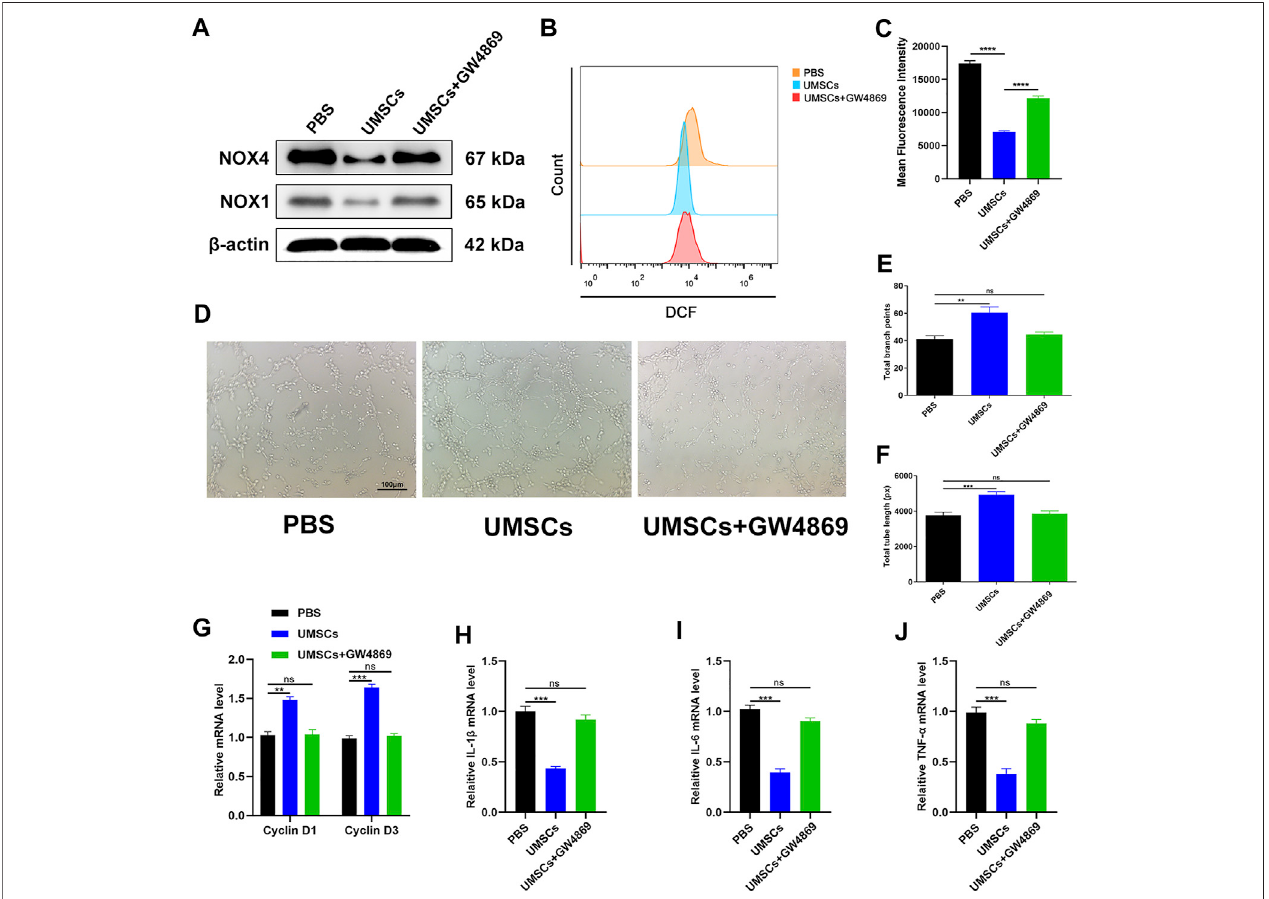
FIGURE2| HUCMSCscanregulateoxidativestressdamageofHUVECsthroughexosomes. (A) WesternblottingresultsofNOX1andNOX4inHUVECsfollowing differenttreatments. (B) ReductionofROSinHUVECsassessedthrough fl owcytometrywiththeDCFH-DAprobefollowingdifferenttreatments. (C) QuantitationofROS depletion measured by the intensity of fl uorescence of HUVECs. (D) A tube formation assay was performed to visualize the cell capillary network formation of HUVECs. Scale bar:100 μ m. (E, F) Quantitative analysisofthetube formation ofHUVECs inthethree groups. (G) RT-qPCRresults ofcyclinD1 and cyclinD3expressionsin theHUVECs followingdifferenttreatments. (H – J) RT-qPCRresultsofIL-1 β ,IL-6,and TNF- α expressionsintheHUVECs followingdifferenttreatments.Differences were measuredbyone-wayANOVAfollowedbyaTukey posthoc testforpairwisecomparison.Datapresentedasmeans ± SD.**** p < 0.0001,*** p < 0.001,** p < 0.01,and * p <